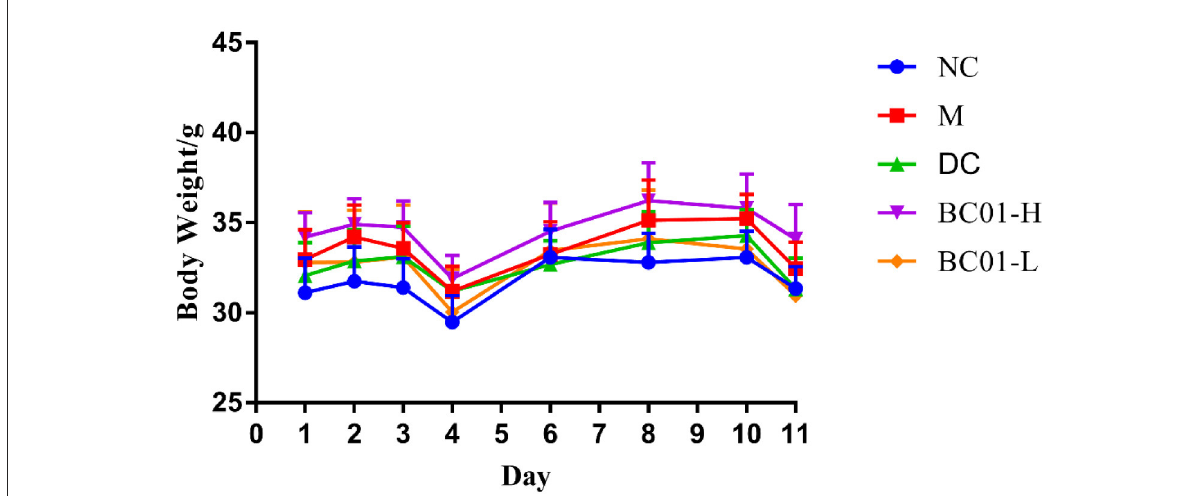
FIGURE1 Changes in the body weights of mice. NC, normal group; M, constipation model group; DC, bisacodyl control group; BC01-H, B. coagulans BC01 high-dose group; BC01-L, B. coagulans BC01 low-dose group ( n = 8).